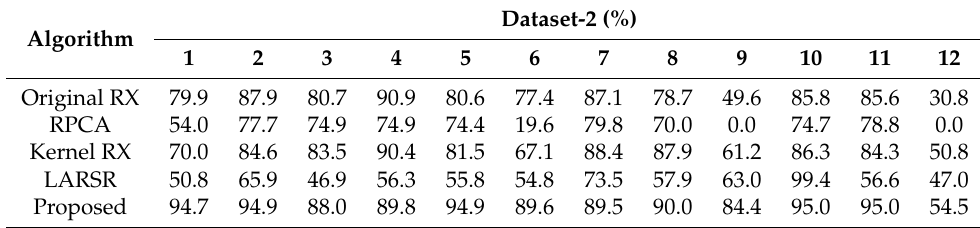
Table 6. Area under the curve (AUC) score for each patches in Dataset-2.